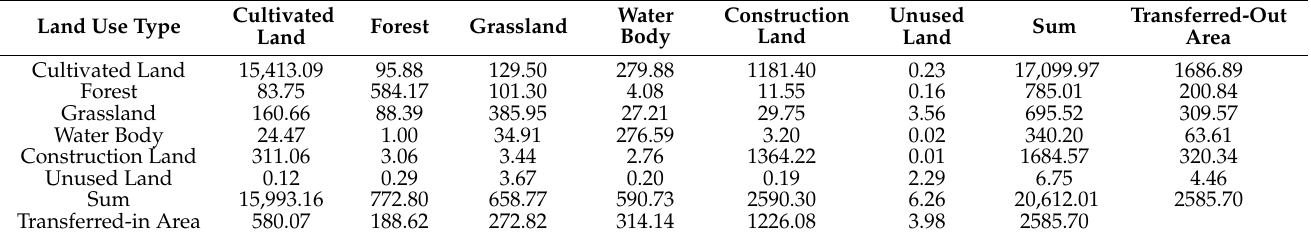
Table 5. Land use transfer matrix in Changchun during 2010–2020 (km 2 ). Cultivated Land Use Type